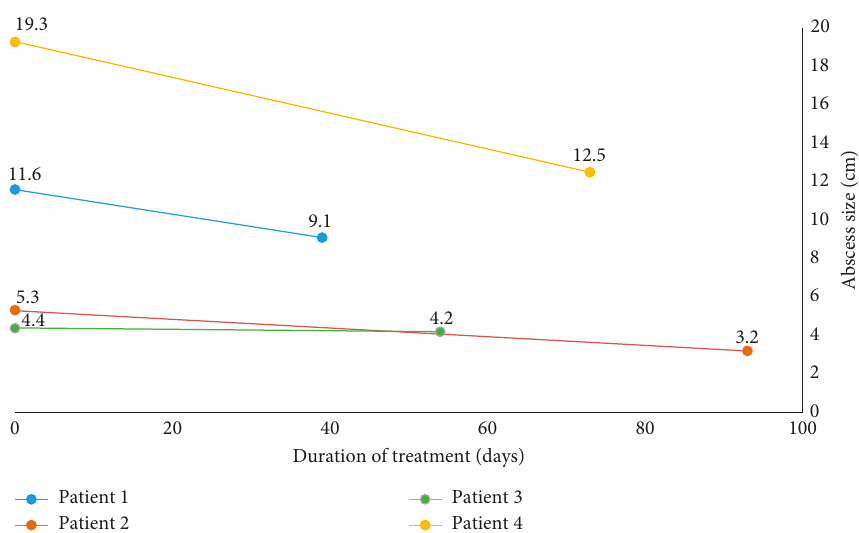
Figure 5: Source control attempt and antimicrobial therapy in patients with persistent intra-abdominal